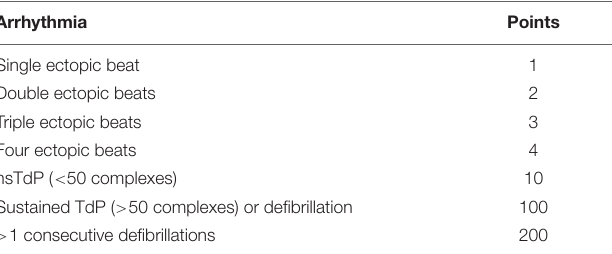
TABLE 4 | Custom-made weighted score of the number and severity of arrhythmias. Arrhythmia